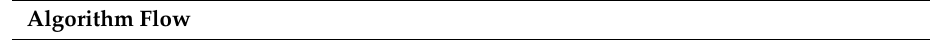
Figure 10. Algorithm flowchart.